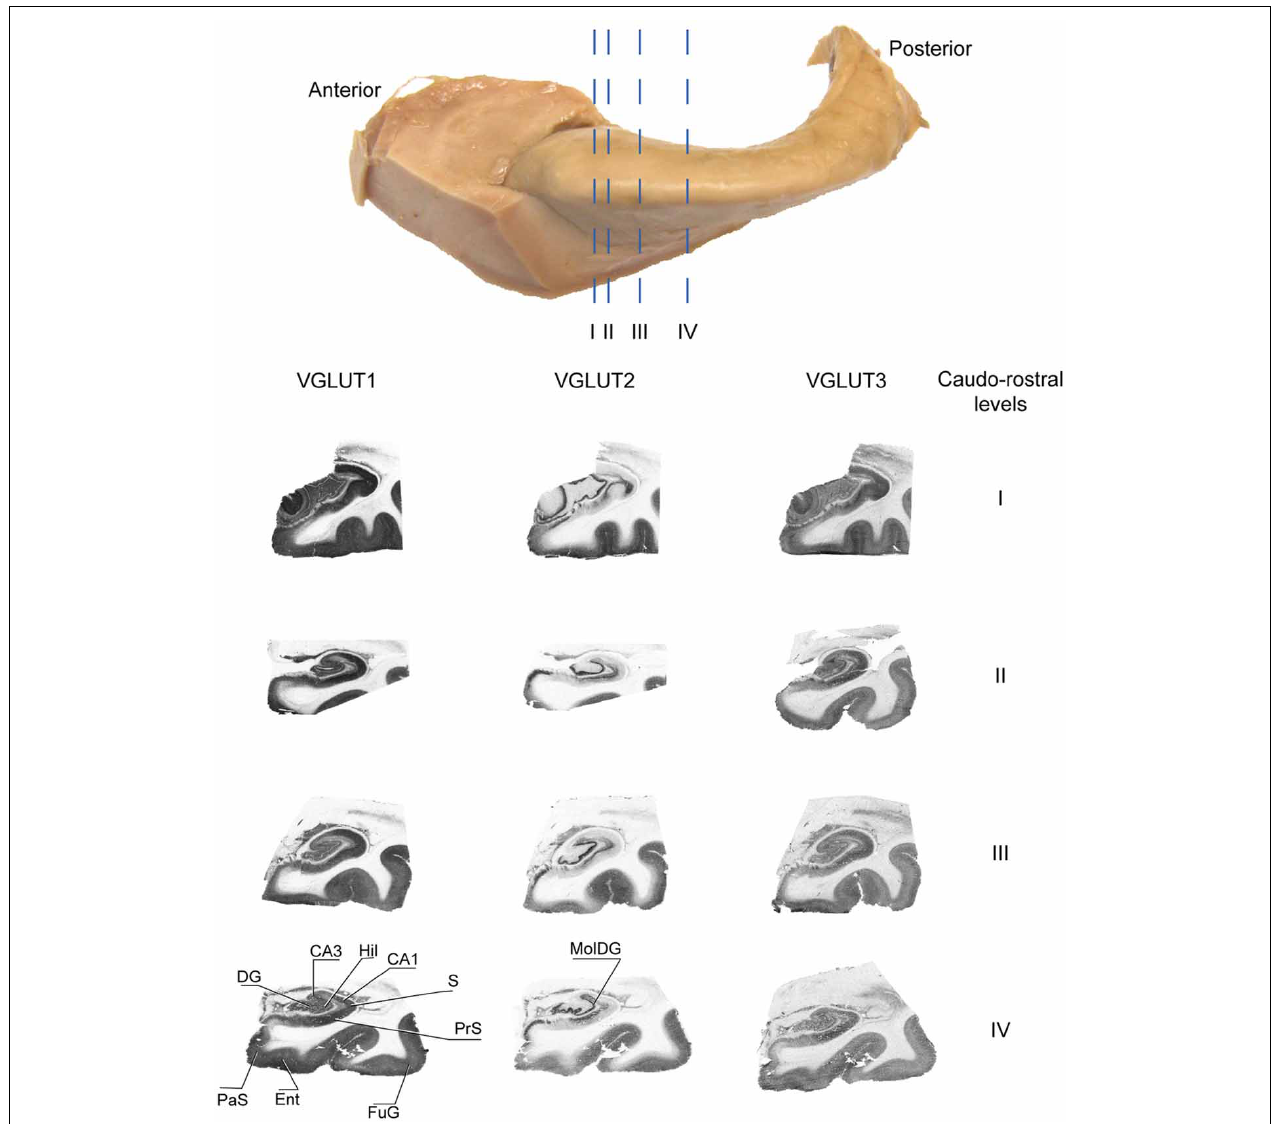
FIGURE 4 | Distribution of VGLUT1-3 proteins at various levels of the antero-posterior axis of the hippocampus. Sections immunolabeled for VGLUT1, VGLUT2, and VGLUT3 were obtained at anatomical levels corresponding approximately to etched lines I-IV. Abbreviations: CA1–3, fields